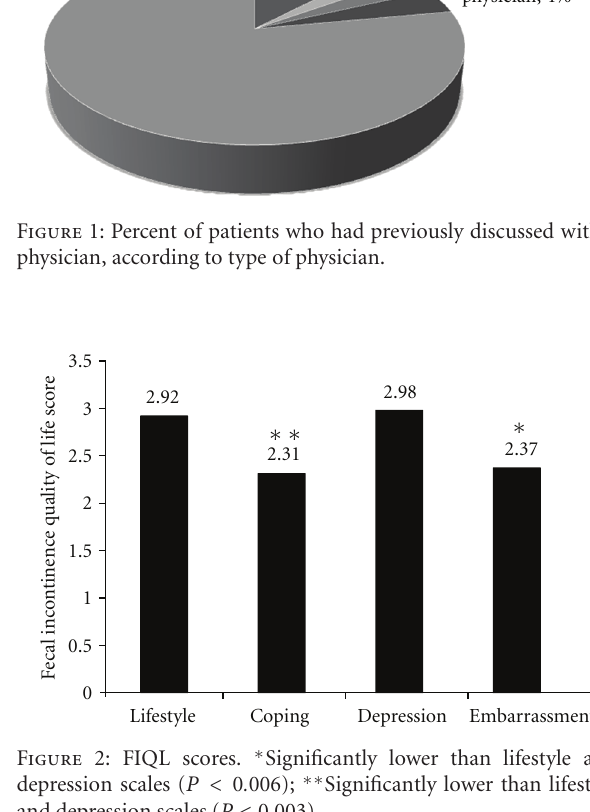
(Figure 2). When combined QOL scores were compared among groups, patients with loose/watery stools had signifi- cantly lower QOL scores when compared against the groups with formed stools ( P = 0 . 005), alternating loose/formed stools ( P = 0 . 05), and all groups combined ( P = 0 . 006) (Table 2). Thirty-two of 58 patients (55%) had high severity scores (FISI score > 25). When severity scores were compared among groups, patients with formed stool had relatively lower severity scores than all other stool-consistency groups alone and combined, although the findings were not signifi- cant. (71%) reported altered stool form (loose/watery, hard, or alternating consistency). Of FI patients with loose/watery 23 (48%) were receiving no medical therapy at all, and only seven of 23 FI patients (30%) were reported using antid- iarrheal agents. See Table 2 for a summary of stool consis- tency, medication use, severity, and quality of life